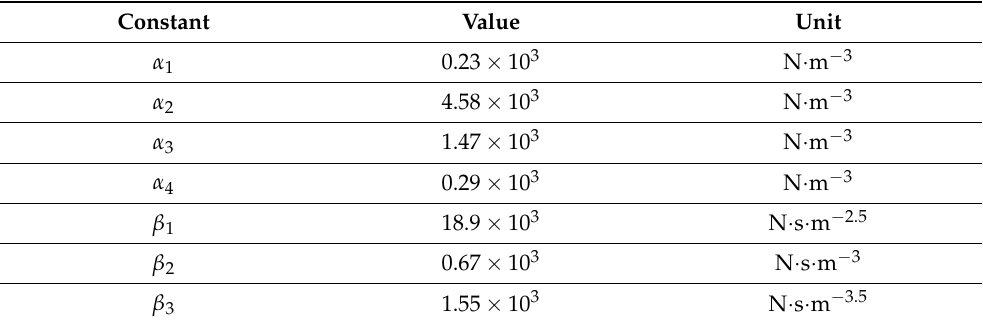
Table 1. Values of constants for ship ice resistance calculations. Reprinted with permission from Ref. [7]. 2009,